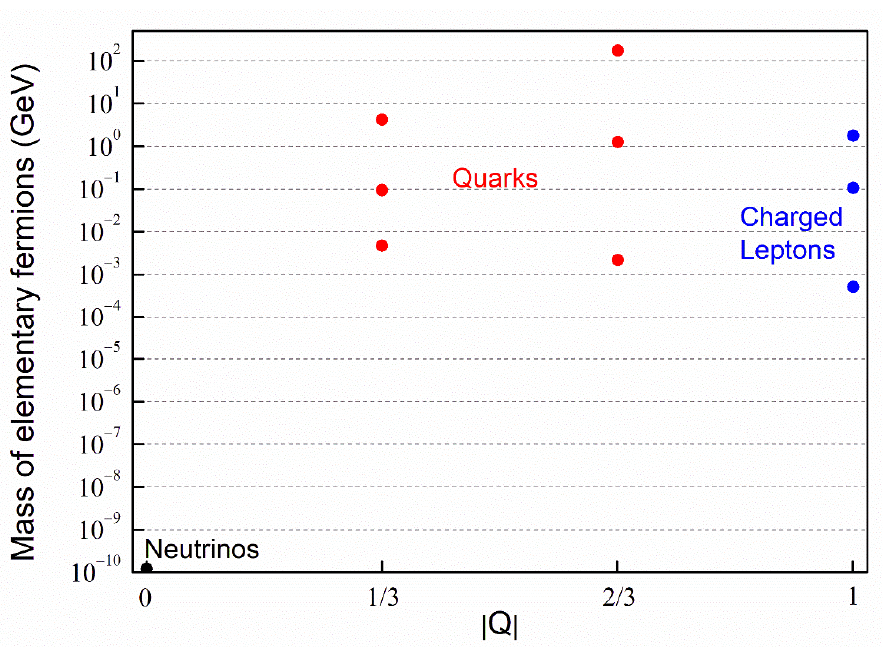
Figure 1. Masses of the elementary fermions of the SM versus the absolute value of the electric charge Q, expressed in units of the electron charge e (see Tables 1 and 2).